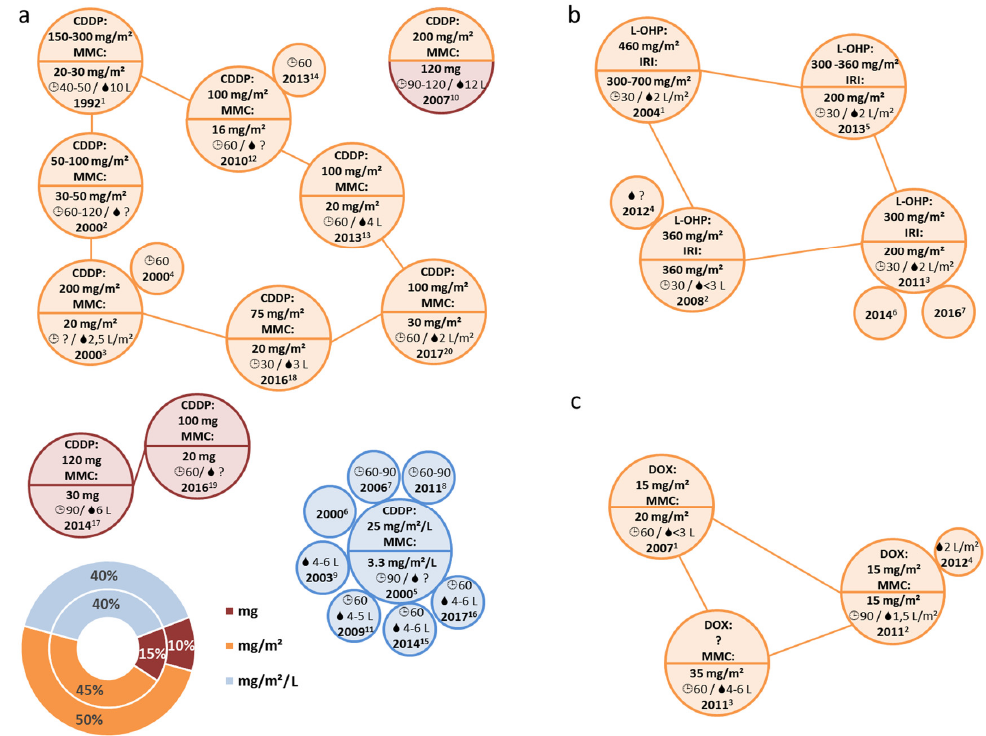
Figure 8. Overview of HIPEC protocols using drug combinations: ( a ) Depiction of different drug dosages and measures thereof (double pie chart with percentages) among protocols using CDDP/MMC combinations ( n = 20). Related publications are annotated by superscript numbers, conforming to annotations in Table S2; further in ( b ) protocols using L-OHP combined with IRI ( n = 7) are annotated conforming to superscript numbers in Table S5; as well as in ( c ) protocols using MMC combined with DOX ( n = 4) conforming to superscript numbers in Table S3. All connections and circle sizes are arbitrary and protocols were compiled manually, according to respective similarities. Abbreviations (amount of diluent); and (HIPEC